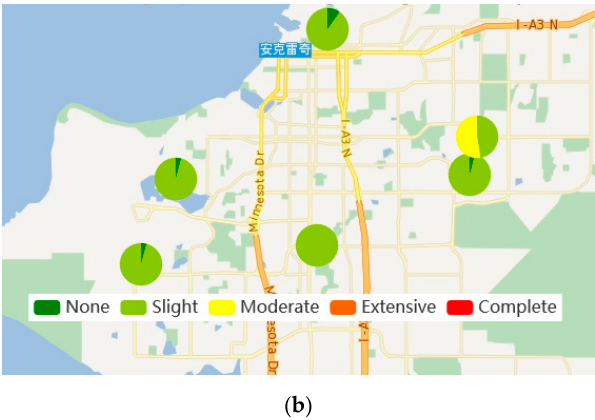
Figure 12. Damage ratio distribution of the buildings near different stations of the 2018 M w 7.0 Anchorage earthquake: ( a ) Global view, and ( b ) local view.